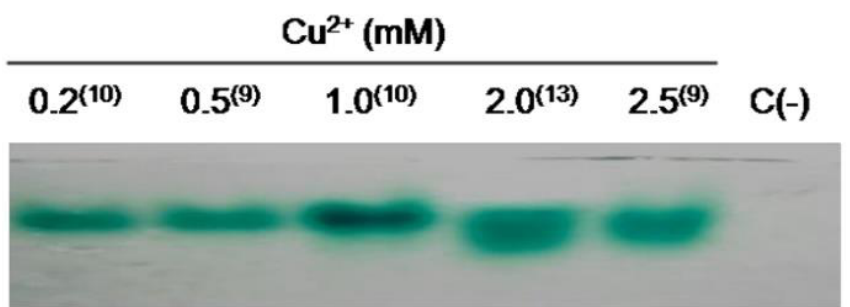
Figure 4. Zymogram analysis of laccase produced by T. terrestris Co3Bag1 in medium HCHN/1 mM CuSO 4 . Zymogram analysis of laccase in medium HCHN supplemented with CuSO 4 (0.2 to 2.5 mM) in the middle logarithmic phase (4th day); samples obtained on the day of maximum laccase activity are shown in brackets. ABTS was used as the substrate.